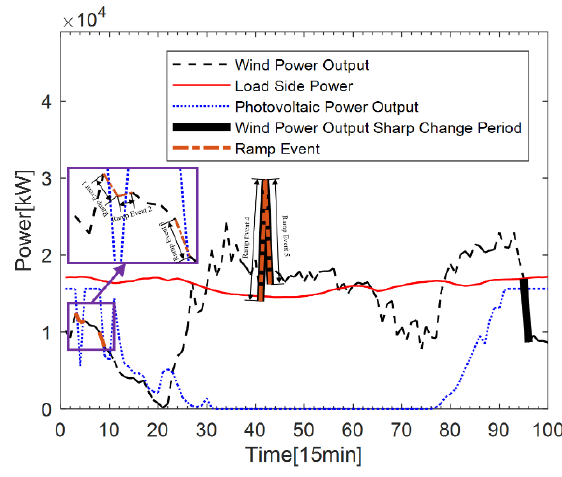
Figure 8. The occurrence of wind power ramp events in grid 2. Table 5. The occurrence of wind power ramp events in grid 2.